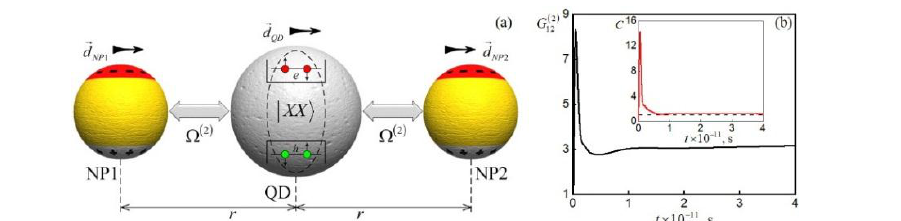
Fig. 1. (a) The model of a three-particle radiative NP-QD-NP spaser. (b) The time dependence of the G and C (inset) functions for photons generated in nonlinear NP-QD-NP cross-correlation   2 12